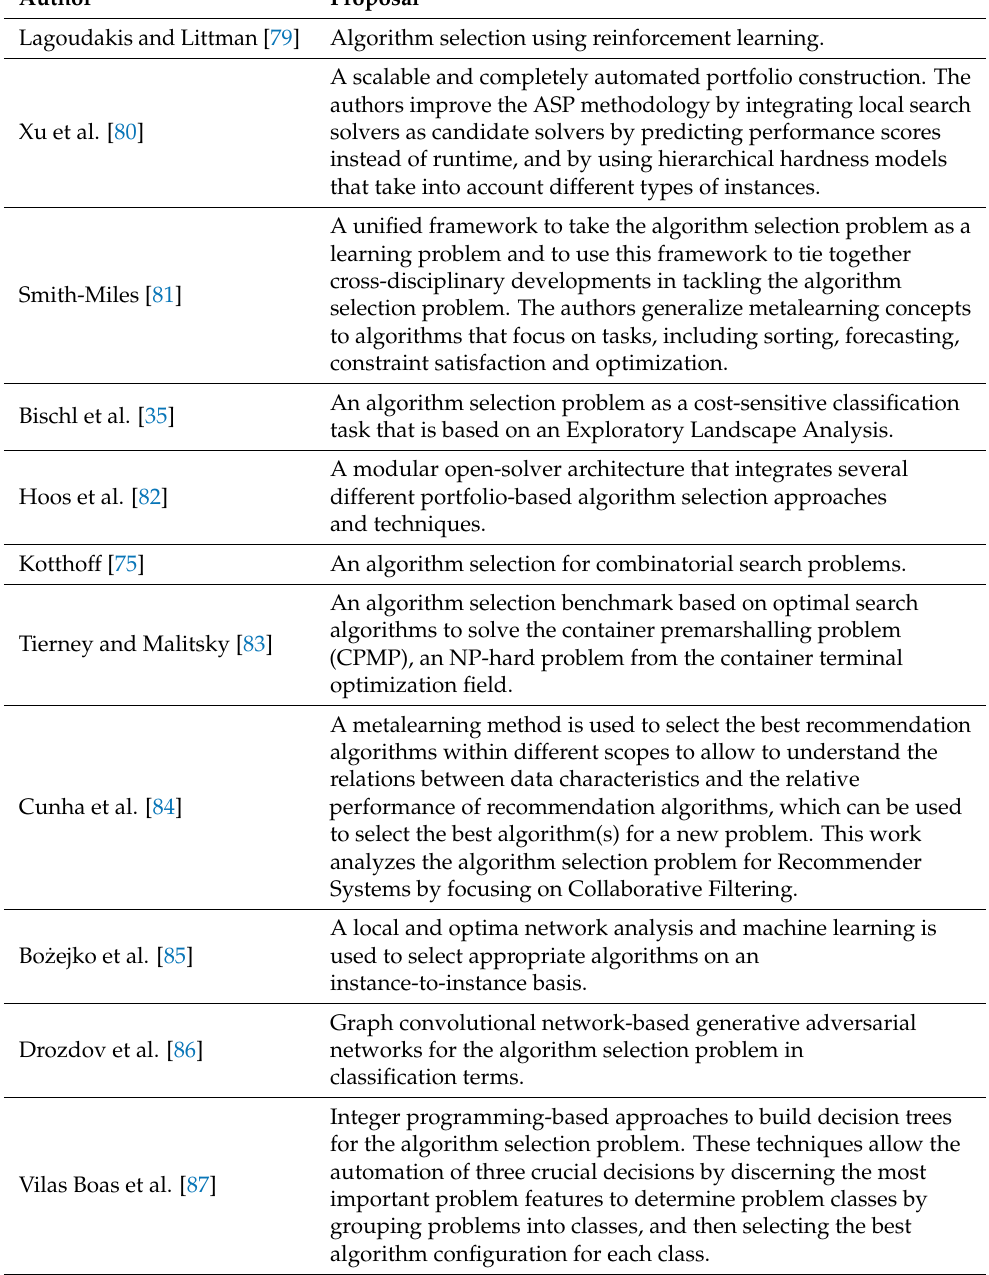
Table 1. Research studies addressing the algorithm selection